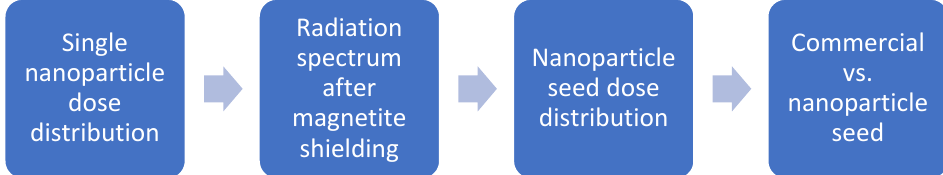
Figure 2. Overview of the simulations performed to characterize the nanoparticle seeds.